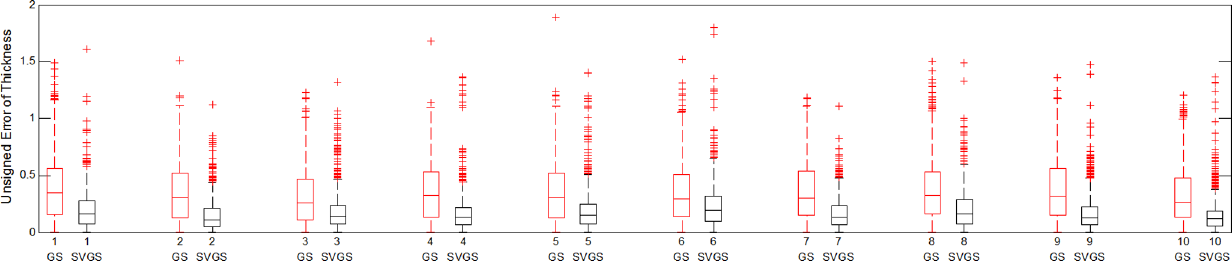
Figure 12. Box plot of unsigned error of tissue thickness among 10 subjects using conventional graph search (GS) and non- Euclidean graph search with subvoxel accuracy (SVGS).